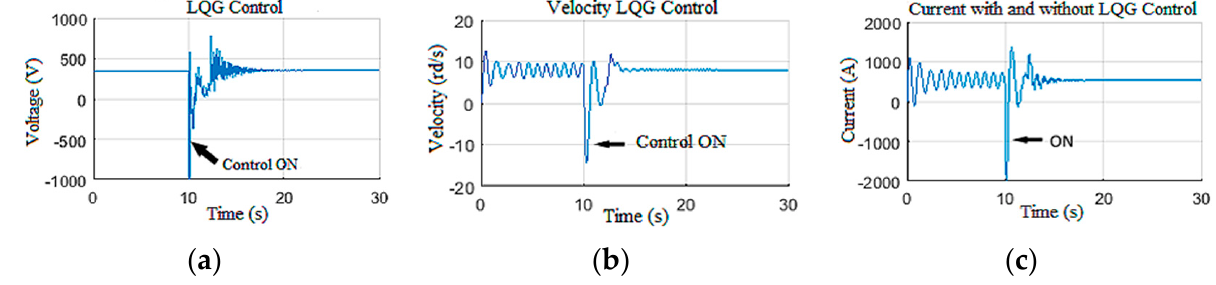
Figure 24. Top drive response for stick-slip suppression: ( a ) voltage; ( b ) velocity; ( c ) current.